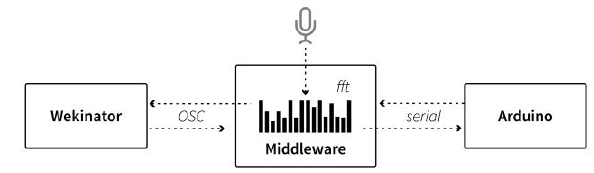
Figure 12 | Software